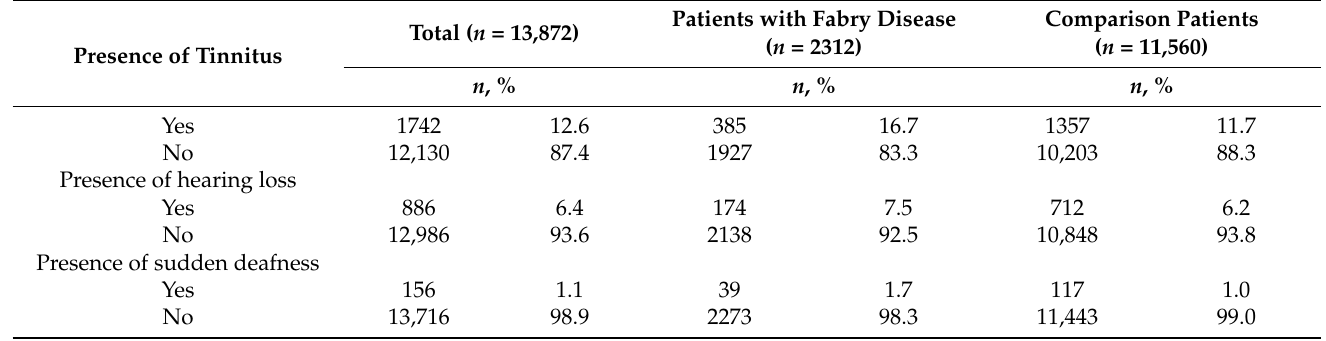
Table 2. Prevalence rates of tinnitus, hearing loss and sudden deafness among patients with Fabry disease vs. comparison patients.